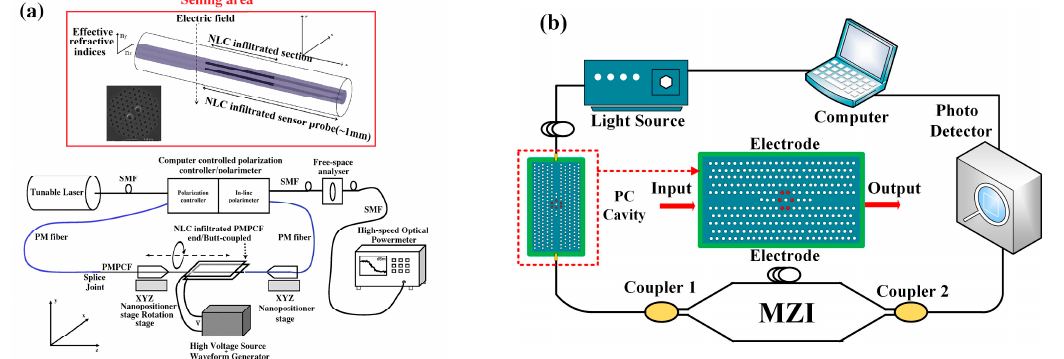
Figure 13. ( a ) electric field sensor probe and sensing system using polarization-maintaining photonic crystal fiber (PMPCF) and nematic liquid crystal (NLC) [94] and ( b ) sensing system based on photonic crystal cavity and liquid crystal (LC) [97]; permission conveyed through the Copyright Clearance Center, Inc.